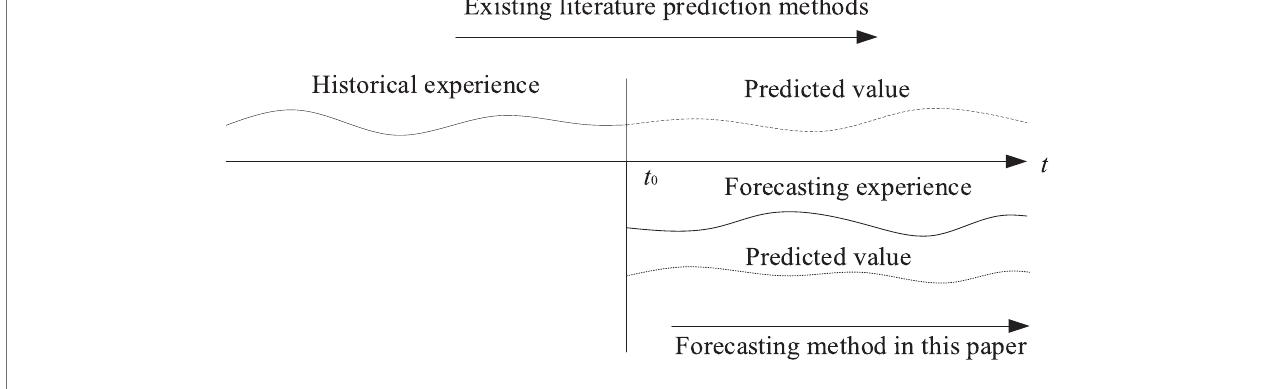
FIGURE 1 | Predictive architecture